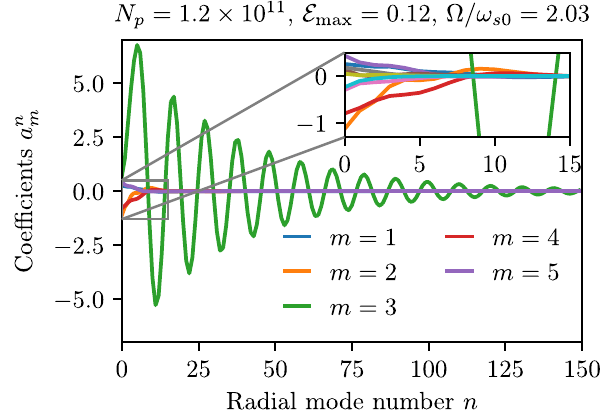
FIG. 12. Coefficients of the orthogonal polynomial expansion according to Eq. (20) for the LLD mode shown as an orange curve in Fig. 11.